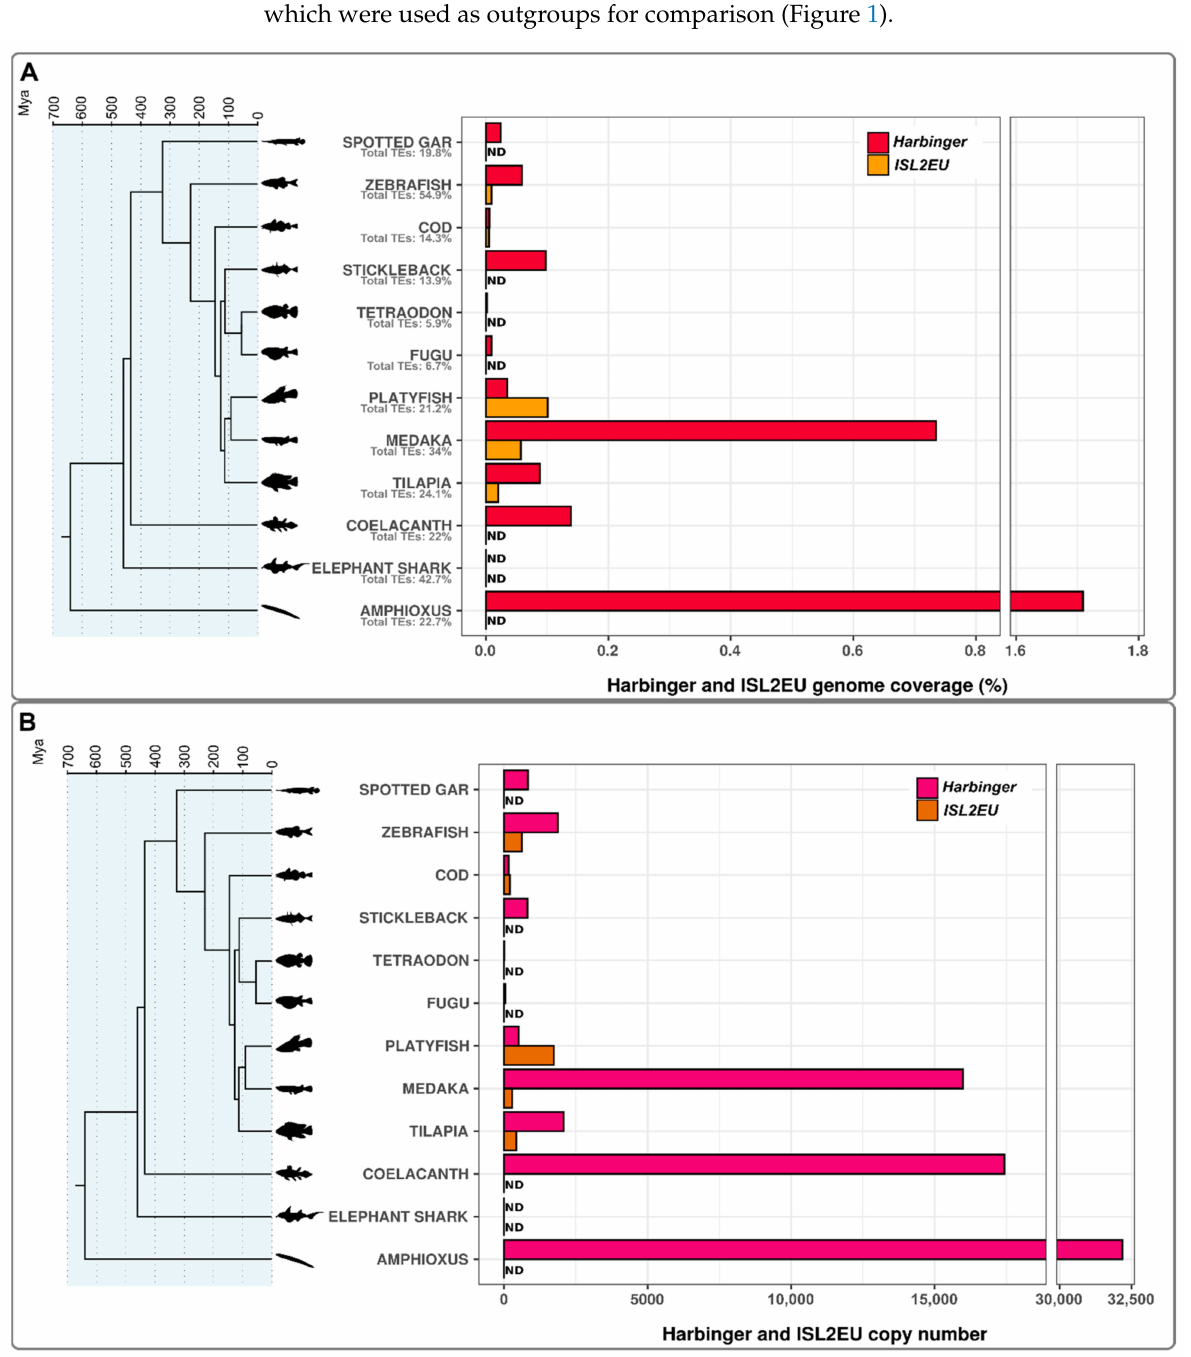
Figure 1. Genome coverage ( A ) and copy number ( B ) of Harbinger and ISL2EU transposons in spotted gar, zebrafish, cod, stickleback, tetraodon, fugu, platyfish, medaka, tilapia, coelacanth, elephant shark and amphioxus. Data were filtered to include only copies longer than 80 nucleotides and sharing more than 80% of identity with the reference sequence from the species-specific library [9]. In ( A ), the global percentage of TEs in genomes is indicated for each species under the species name. ND (not detected) is indicated when no element was detected in the species. Species phylogeny was based on divergence times estimated using the TimeTree public database